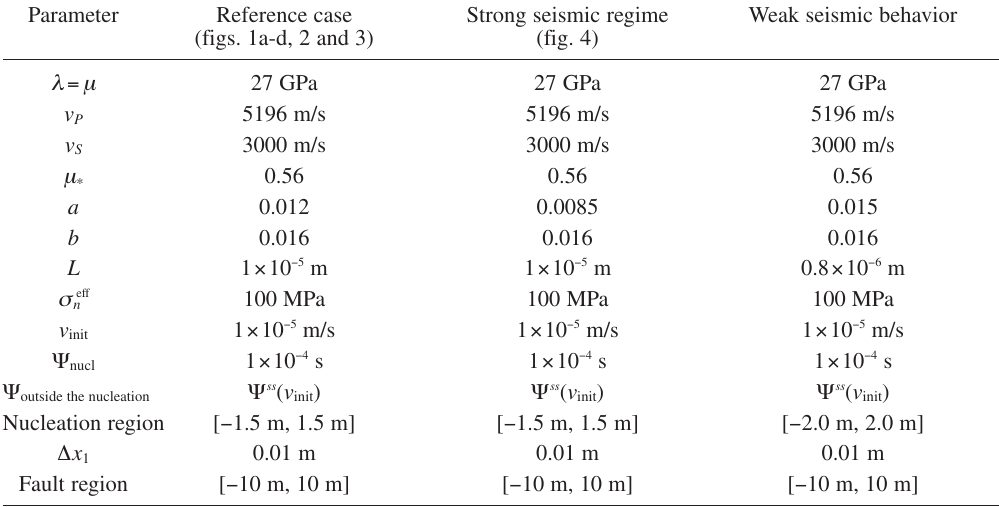
Table II. Model and constitutive parameters used for the simulations on a homogeneous fault. This set of pa- rameters refers to a laboratory-scale experiment. Parameter Reference case Strong seismic